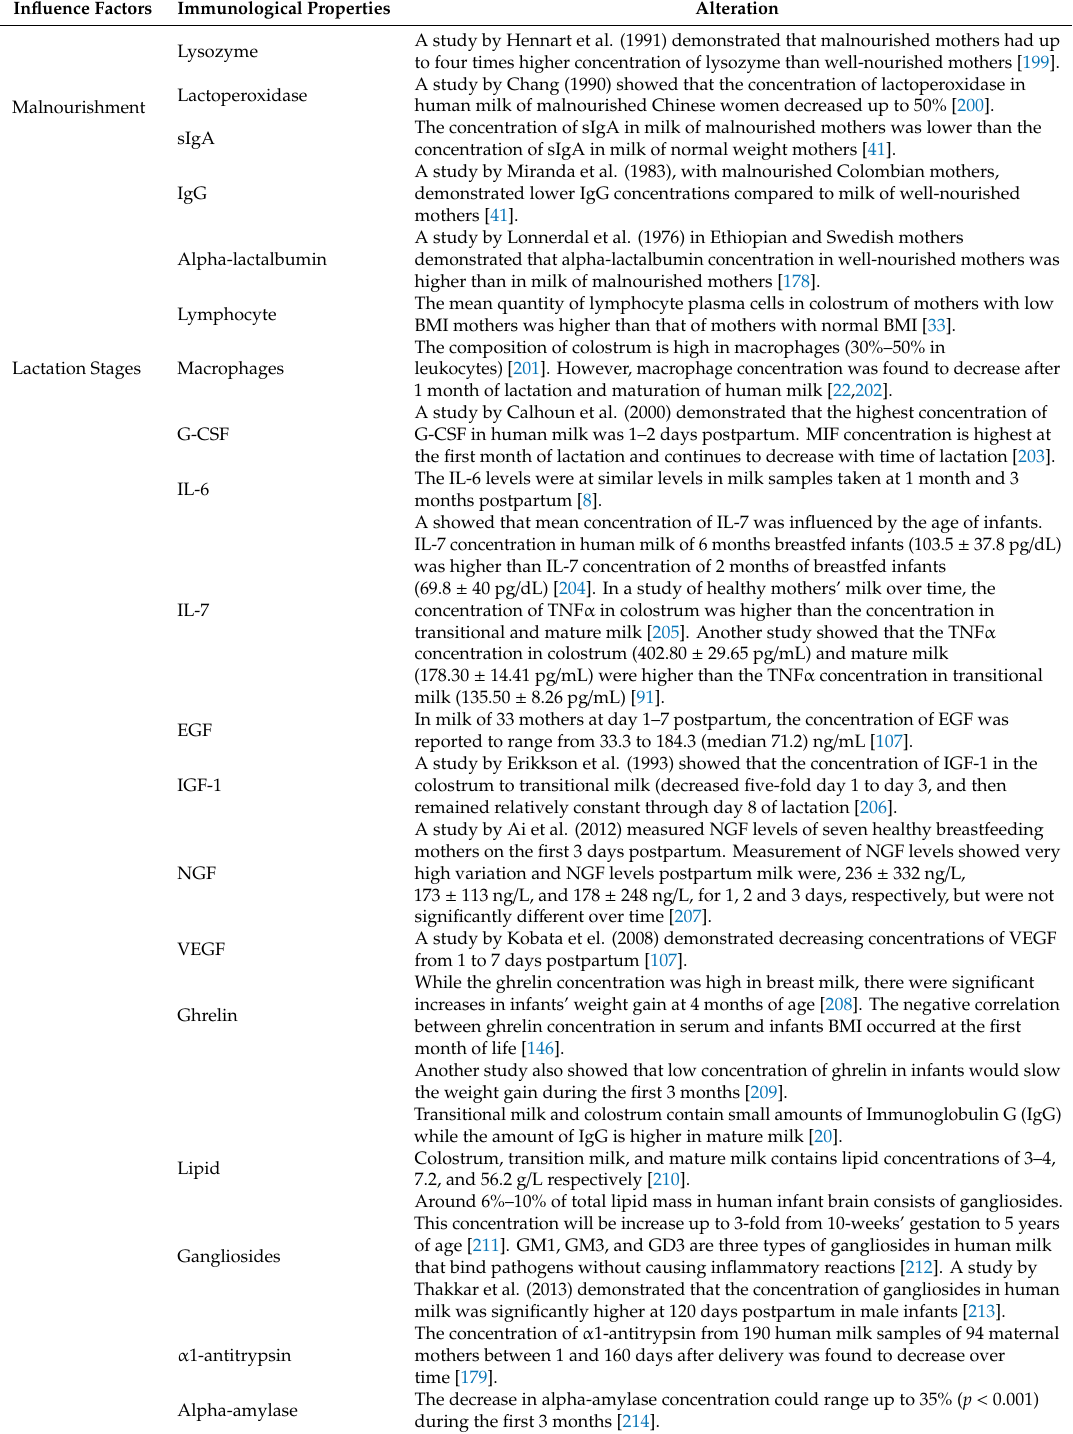
Table 2. Alteration of immunological properties by other influential